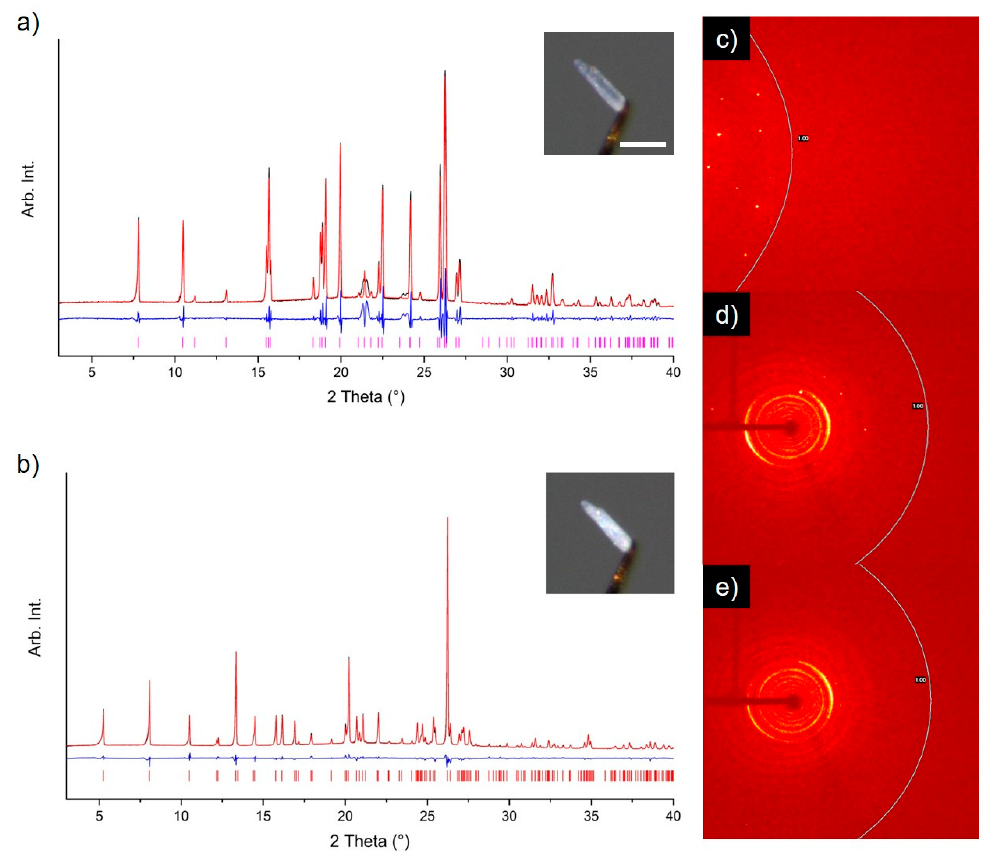
Figure 6. ( a ) XRPD pattern obtained from a “wet” TMA:DMF slurry. The pattern has been fitted (Pawley) using the unit cell parameters of the new Pmn 2 1 polymorph of the DMF solvate. ( b ) XRPD pattern obtained from a “dried” sample of the TMA:DMF slurry. The pattern has been fitted (Rietveld) to the previously known polymorph (CSD: XAVPOZ) of the DMF solvate. For both plots, the experimental pattern is shown in black, calculated pattern in red, difference plot in blue and tick marks represent expected reflections for the fitted phases. The inset images show the transformation of ( a ) a single crystal of the Pmn 2 1 phase isolated from the slurry to the ( b ) XAVPOZ phase within minutes of isolation (296 K, in air). The crystal is mounted on a Kapton microloop, and the scale bar shown in ( a ) represents a distance of 100 µm. The change in diffraction obtained from a crystal of the Pmn 2 1 phase over the period of 2 h is shown in ( c – e ), where the highlighted ring represents 1.0 angstrom resolution.